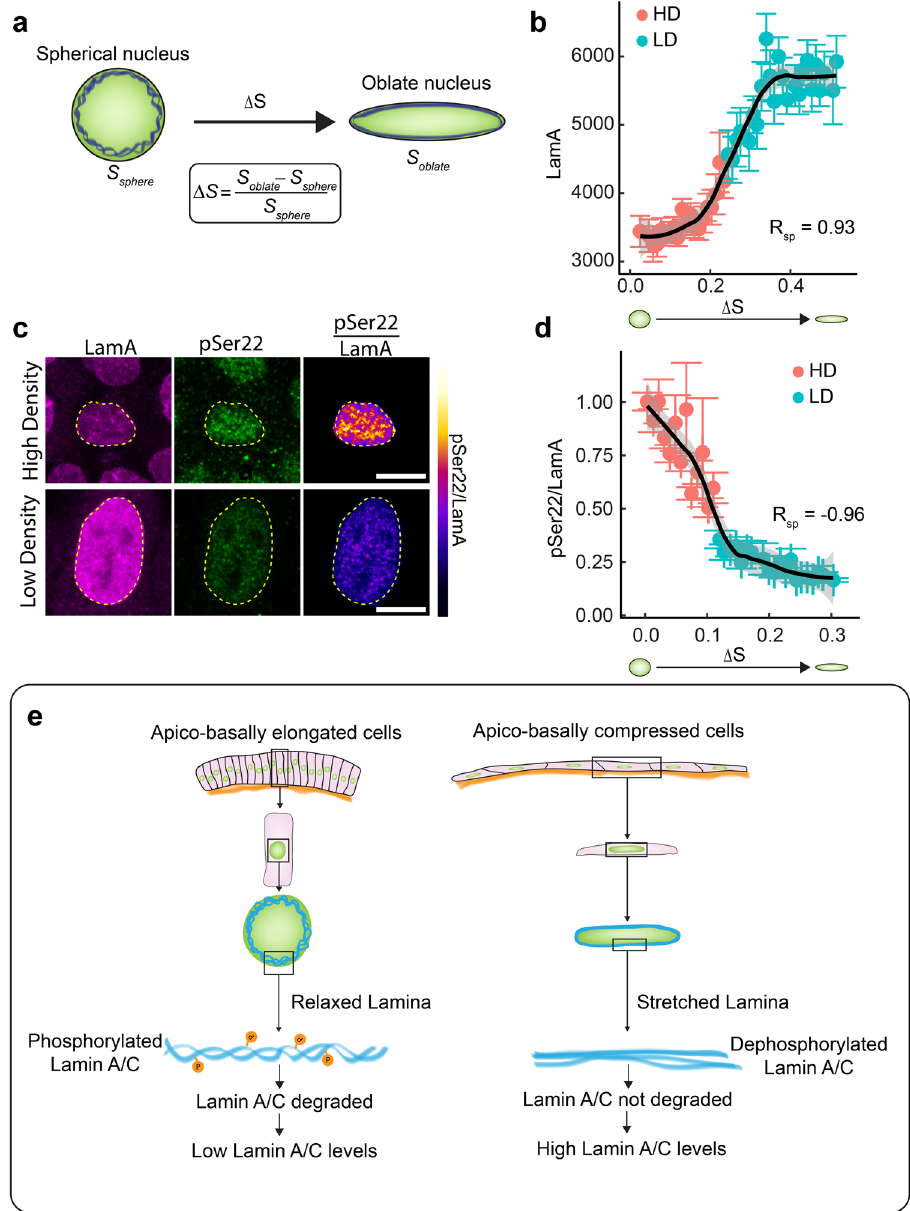
Fig. 7 Lamina network stretching induced dephosphorylation of Lamin A/C regulates Lamin A/C levels in epithelial tissues. a Schematic showing the stretching of nuclear lamina (blue) when a sphere is compressed to an oblate spheroid. The surface area strain, represented by Δ S is the change in surface area of the oblate spheroid as compared to the surface area of the sphere. b Binned scatter plot between Surface area strain ( Δ S) and Lamin A generated by binning Δ S in bins of 0.01. Each point in the plot represents the mean value of Δ S and LamA in the bin. The red points represent data from HD culture and cyan points represent data from LD culture. Solid black line shows the LOESS regression to the data. Spearman ’ s rank correlation coef fi cient between Δ S and LamA R sp is 0.93. c Images showing Lamin A(magenta), pSer22 (green) and pSer22/LamA ratio (color-coded) in cells plated in high density (top panel) or low density (bottom panel). Scale bar, 10 µ m. d Binned scatter plot between surface area strain ( Δ S) and pSer22/LamA generated by binning Δ S in bins of 0.01. Each point in the plot represents the mean value of Δ S and pSer22/LamA in the bin. The red points represent data from HD culture and cyan points represent data from LD culture. Spearman ’ s rank correlation coef fi cient between Δ S and pSer22/LamA, R sp is − 0.93. Solid black line shows the LOESS regression to the data. Data are presented as mean values ± S.E.M. e A model elaborating the apico-basal cell compression mediated regulation of Lamin A/C in epithelial